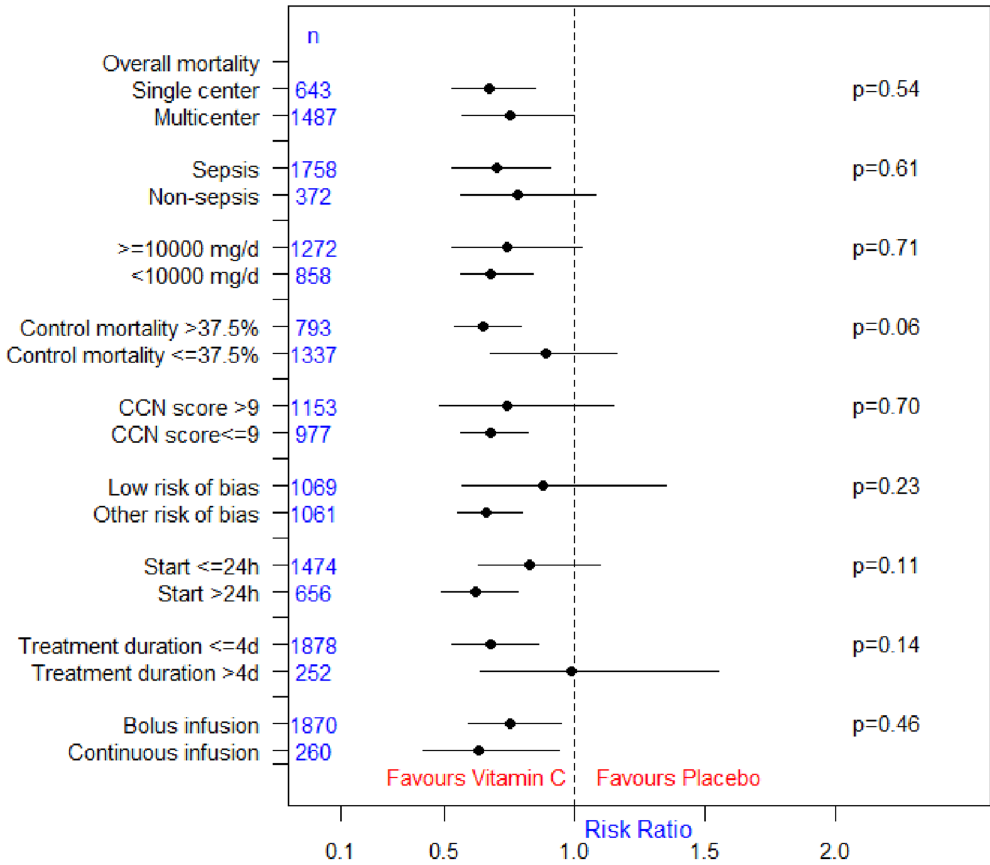
Fig. 3 Subgroup analysis for overall mortality. CCN critical care nutrition